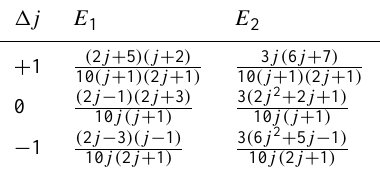
Figure 1. Data of the solar extraterrestrial spectrum in the region 586–594nm measured by SCIAMACHY on 3 June 2010 and from the Smithsonian Astrophysical Observatory (SAO; Chance and Kurucz, 2010). The Fraunhofer lines are readily observed and the left figure shows both the SCIAMACHY and the SAO 2010 spectrum, from which the baseline value of 5 . 44 × 10 14 photon used in the approximate formula by McNutt and Mack (1963). The right figure shows the SAO 2010 spectrum compared to the fully resolved approximation of the D 1 and D 2 lines taken from McNutt and Mack (1963). Note that the approximate formula by McNutt and Mack (1963) is only valid close to the center of the Fraunhofer lines. The fully resolved Na Fraunhofer lines are much deeper than the lines in the SAO 2010 spectrum and the SCIAMACHY spectrum.